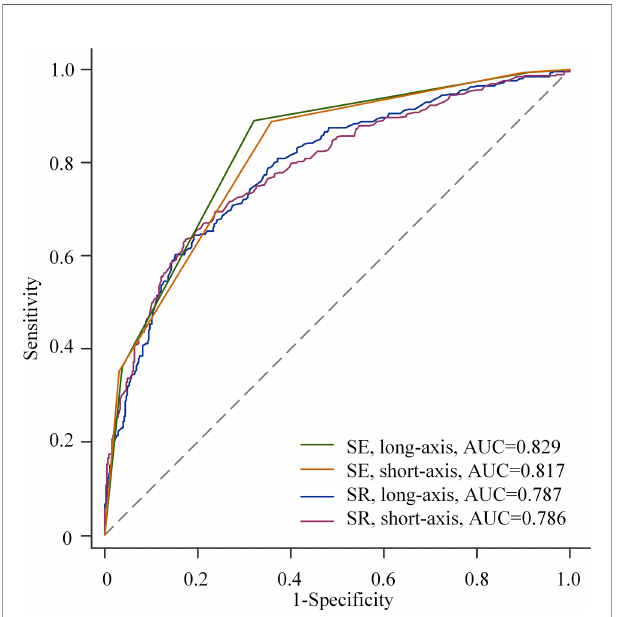
FIGURE 5 | Receiver operating characteristic (ROC) curves for B-mode ultrasound (B) alone, B-mode ultrasound combined with elasticity score (ES), and/or strain ratio (SR). Among the three combinations, the AUC of BI-RADS classi fi cation combined with SR was the highest, and that of BI-RADS classi fi cation combined with SE was the lowest (0.846 vs . 0.824, p = 0.001; 0.846 vs. 0.783, p < 0.001; 0.824 vs . 0.783, p <